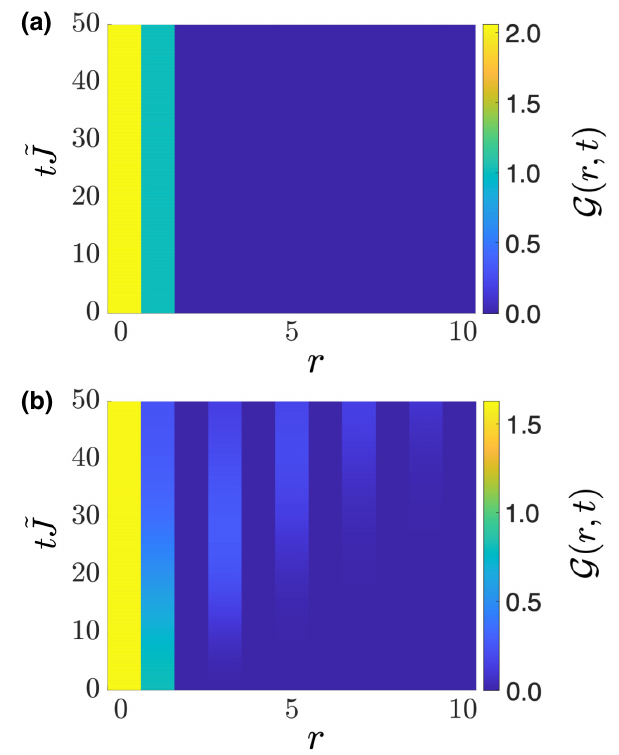
FIG. 6. The time evolution of G ( r , t ) as a function of r and t ˜ J : (a) m = − 5 ˜ J ; (b) m = 5 ˜ J